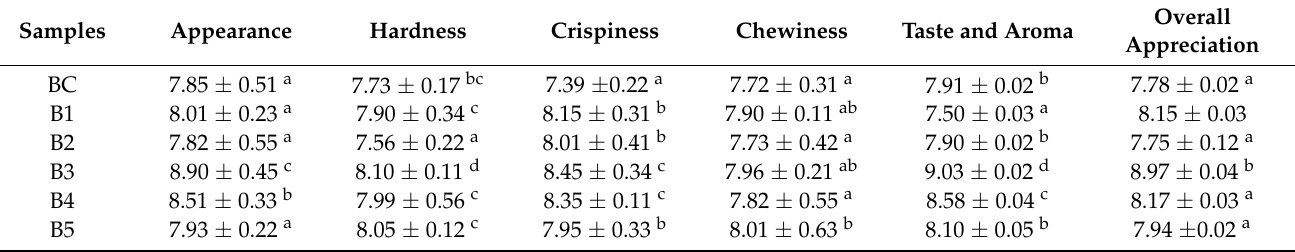
Table 9. Sensory evaluation of